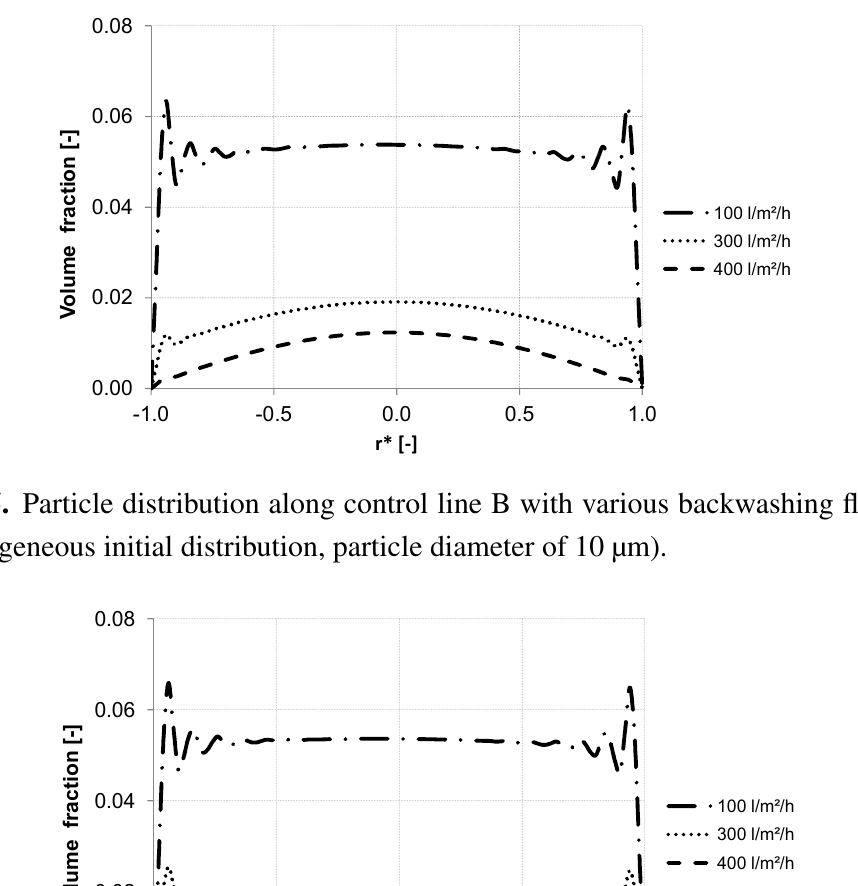
Figure 14. Particle distribution along control line A with various backwashing fluxes after 8 s (homogeneous initial distribution, particle diameter of 10 µm).